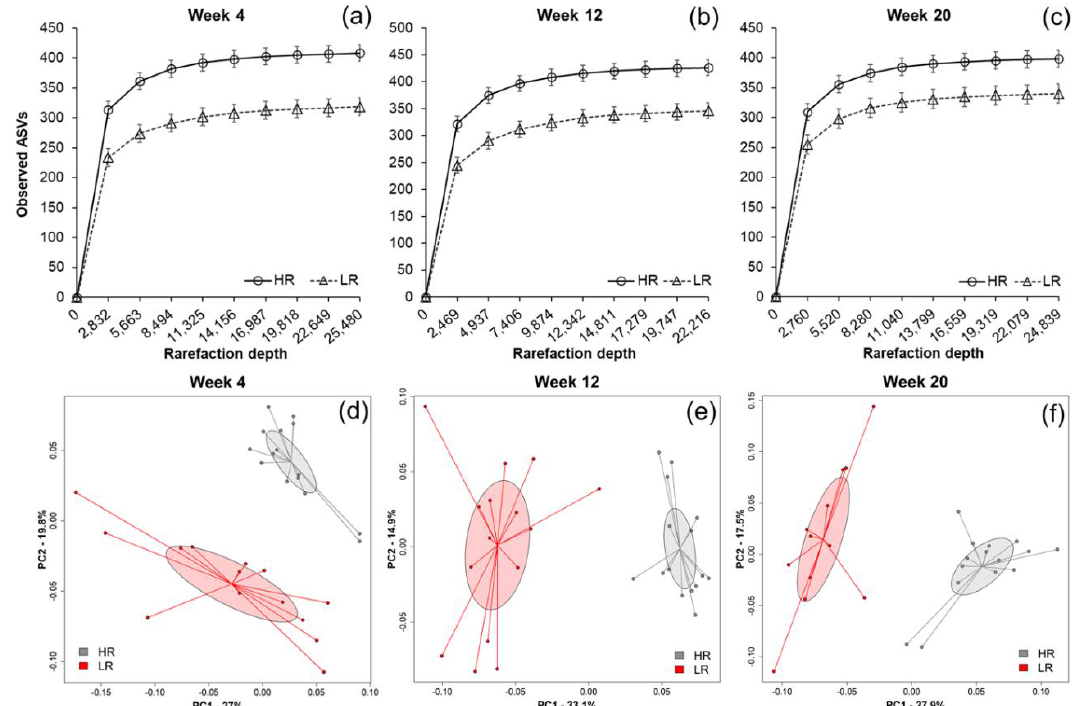
Figure 1. Alpha rarefaction curves ( a – c ) at each time collection point describing the number of observed amplicon sequence variants (ASVs) ( y -axis) as a function of sequencing depth ( x -axis); principal coordinates analysis (PCoA) plots of Weighted UniFrac metrics ( d – f ) representing individual fecal communities ( • , high-risk (HR); • , lower-risk (LR)) at each collection point. Confidence ellipses are presented in color for each dietary group (99% CI based on standard error).